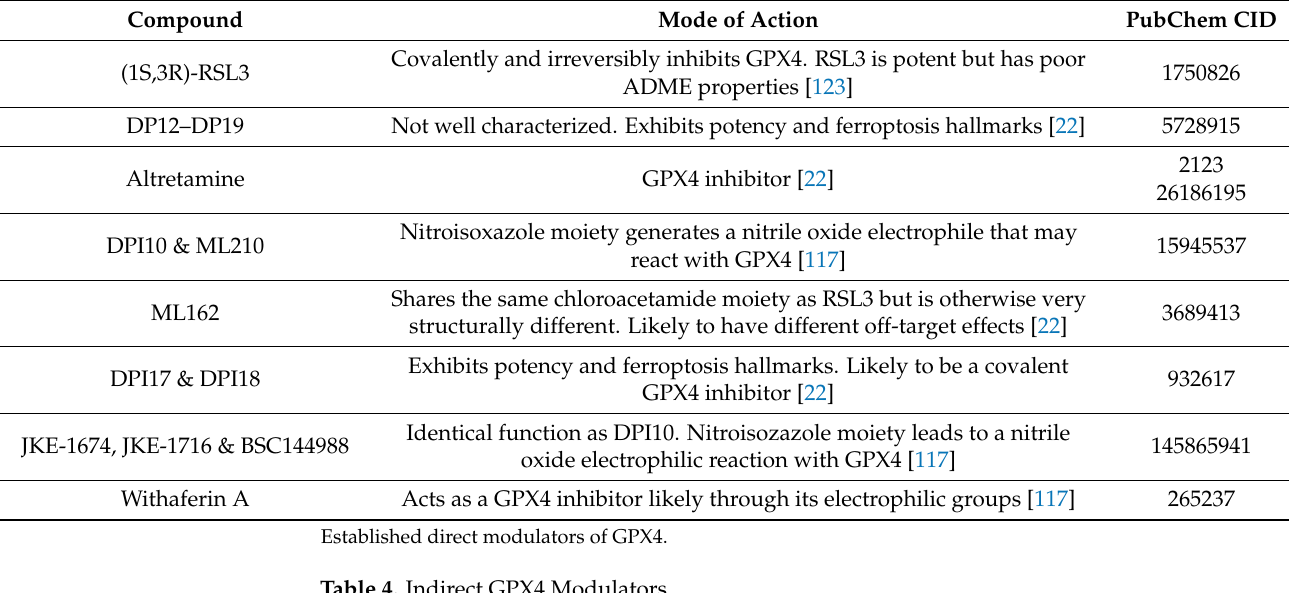
Table 3. Direct GPX4 Modulators.